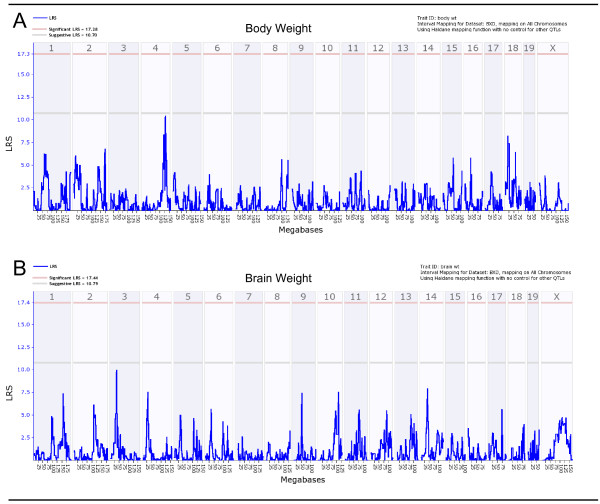
Genome-wide linkage maps of body and brain weights. Linkage maps of body weight (A) and brain weight (B) show no significant or suggestive peaks that overlap with total PMBSF area QTL. Lower gray horizontal line: suggestive LRS genome-wide threshold at p ≤ 0.63. Upper red horizontal line: significant LRS genome-wide threshold at p ≤ 0.05.